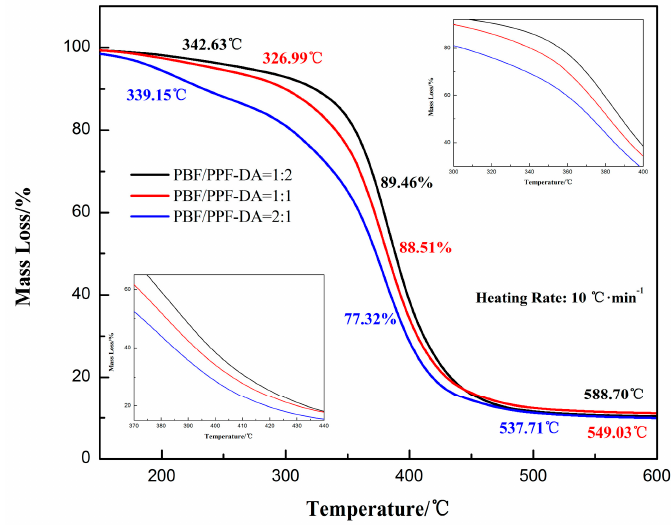
Figure 4. Thermogravimetric analysis (TGA) plot curves of the PBF/PPF-DA polymer networks with double-bond ratios of 0.5, 1 and 2. Materials 2017 , 10 , 149